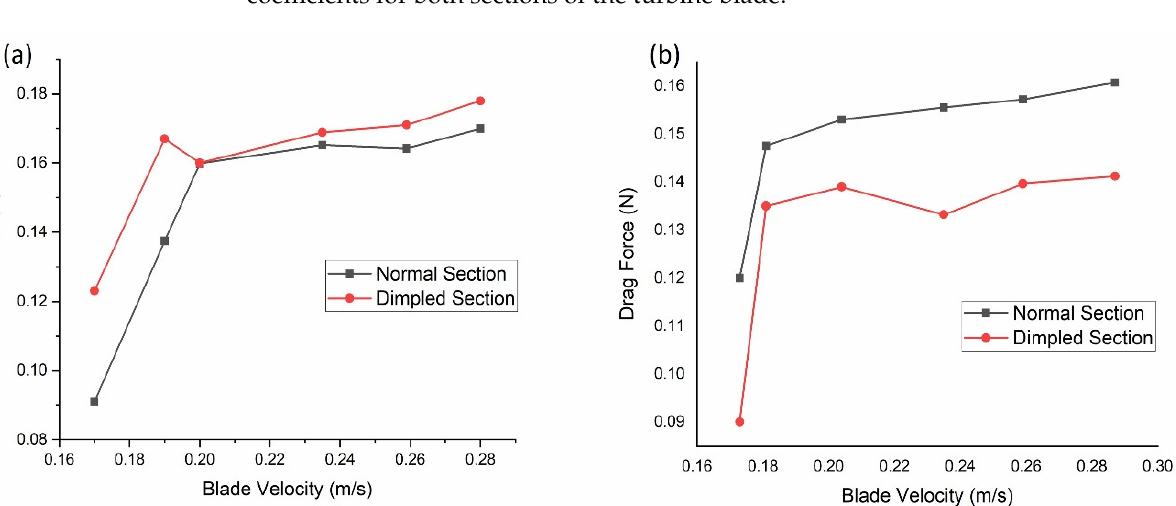
Figure 9. Variation of ( a ) lift force and ( b ) drag force due to blade velocity.